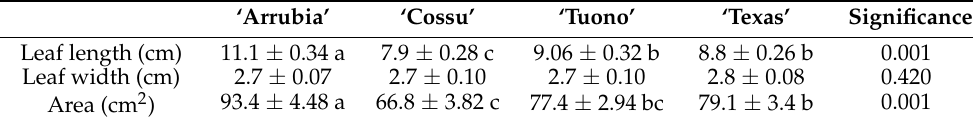
Table A2. Average dimensions and leaf area of fully expanded leaves of the four varieties. Values are mean (n = 15) ± standard error. Different lowercase letters indicate significant differences among